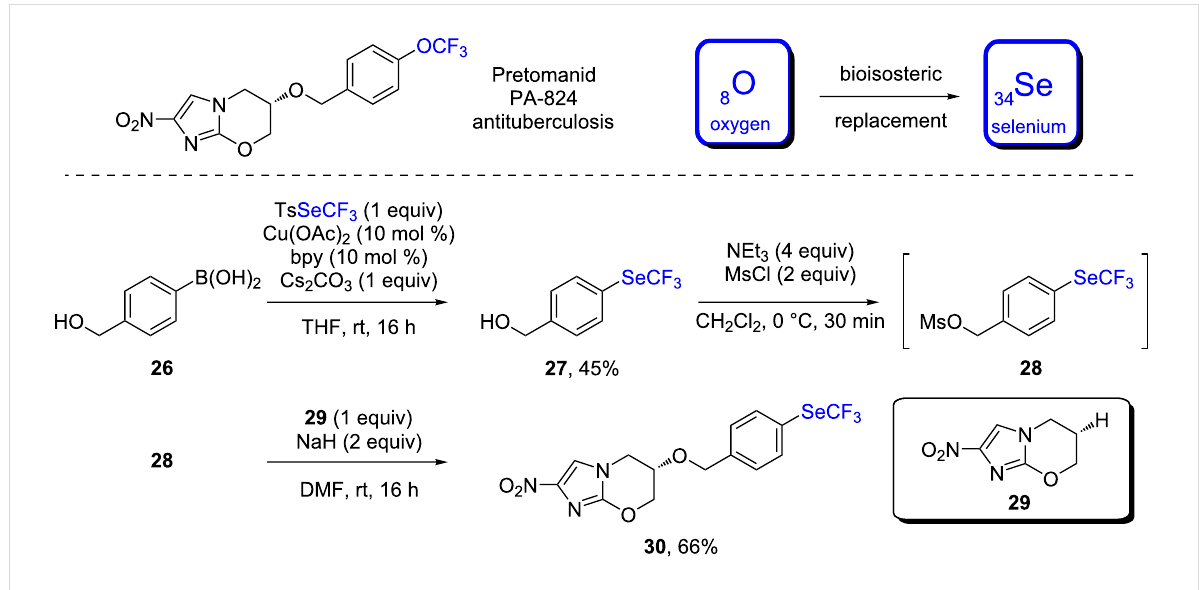
Scheme 14: Copper-catalyzed synthesis of a selenylated analog 30 of Pretomanid developed by the group of Tlili and researchers from